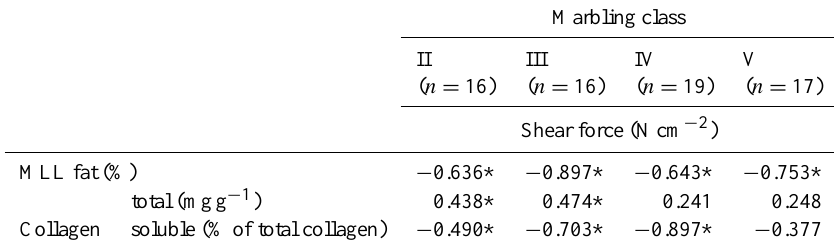
Table 3. Coefficients of Pearson’s correlation of shear force with fat and collagen content.